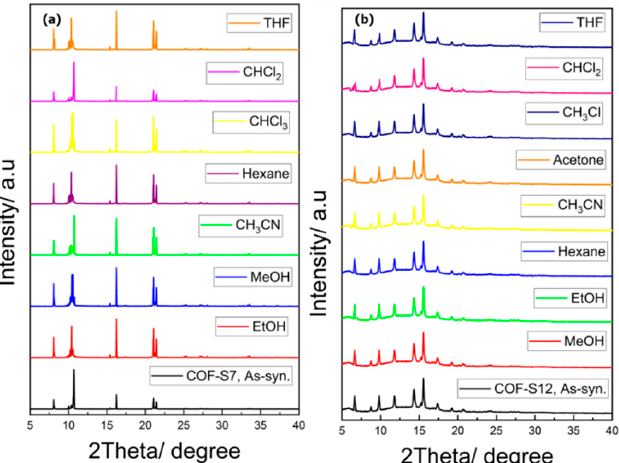
Figure 2. PXRD spectra of as-synthesized COFs with different solvents for chemical stability study ( a ) COF-S7 and ( b ) COF-S12.